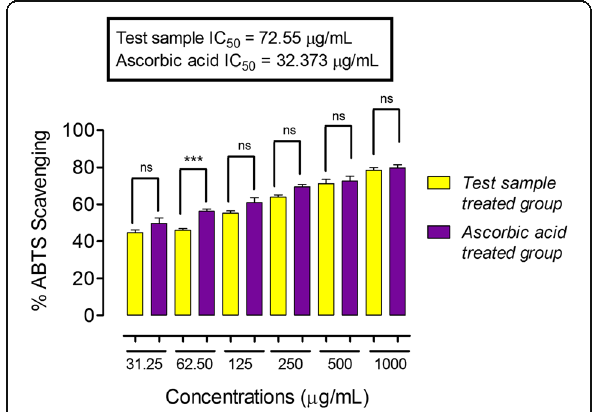
Fig. 4 Results of antioxidant potentials of Olax nana using ABTS free radicals scavenging assay. Values significantly different in comparison to the positive control (ascorbic acid) and test samples at the same concentration, at 95% confidence interval. *** P < 0.001, ns: values not significantly different in comparison to % inhibition of the positive control ( P > 0.05) at the same concentration. One-way ANOVA followed by Bonferroni ’ s multiple comparison post hoc test